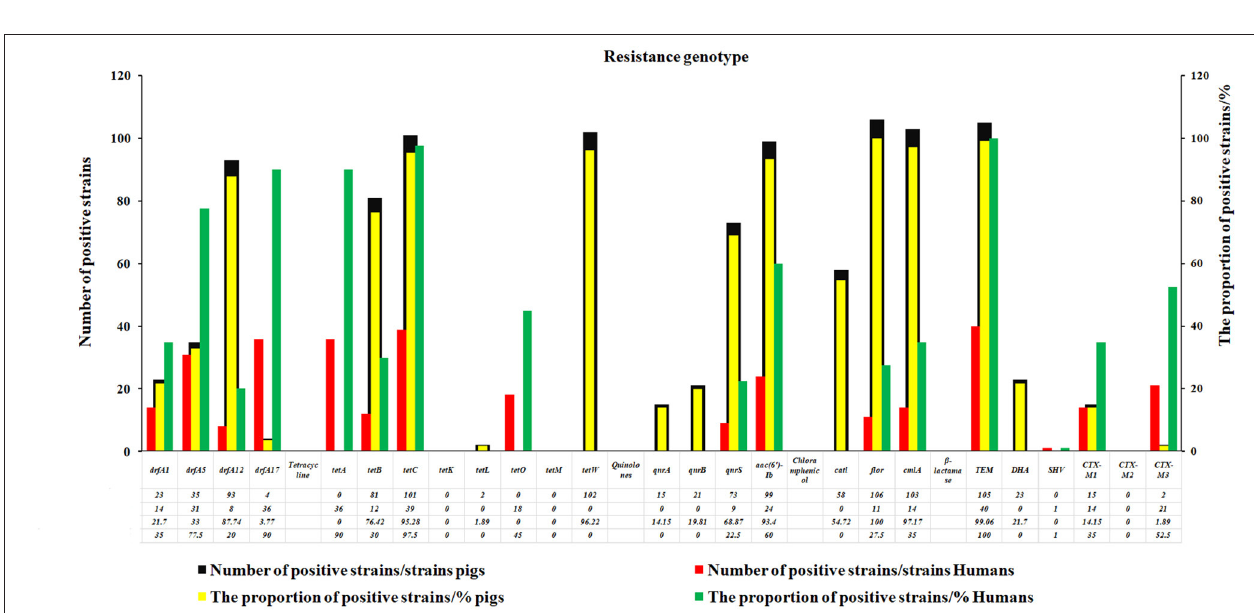
FIGURE 3 | The resistance genotypes of the swine and human E. coli strains. In this study, 26 genotypes of antibiotics commonly used in clinic were studied. The results revealed that the detection rate of C-resistant flor gene (100%) was the highest one in E.coli of swine origin, followed by bla TEM gene (99%) of β -lactamases and cmlA gene of Cs (97.17%), tetW genes (96.22%), and tetC gene (95.28%) of TEs, the qac E 1 1-sulI gene of SXT (93.4%) and quinolones aac (6 ′ )-Ib gene (93.4%).